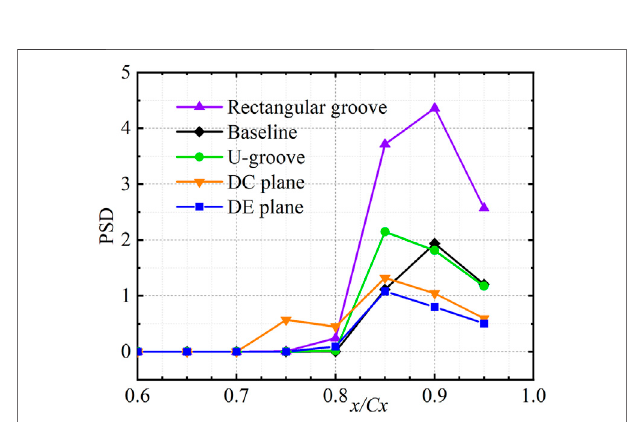
FIGURE 13 | Growth rate of most-ampli fi ed